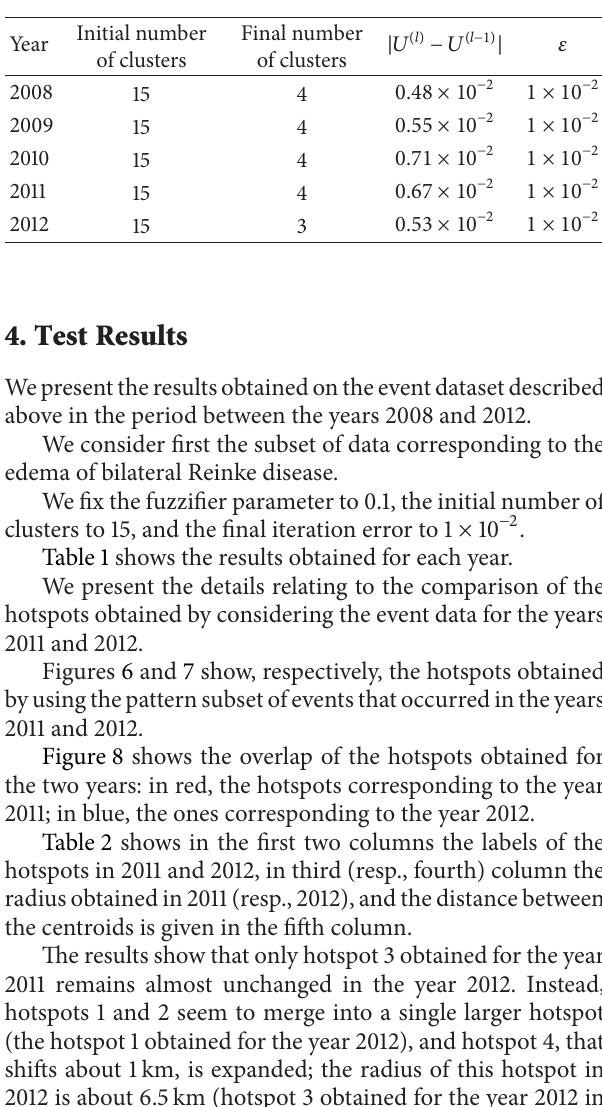
Table 1: Endema of bilateral Reinke disease—final number of clusters and final error for